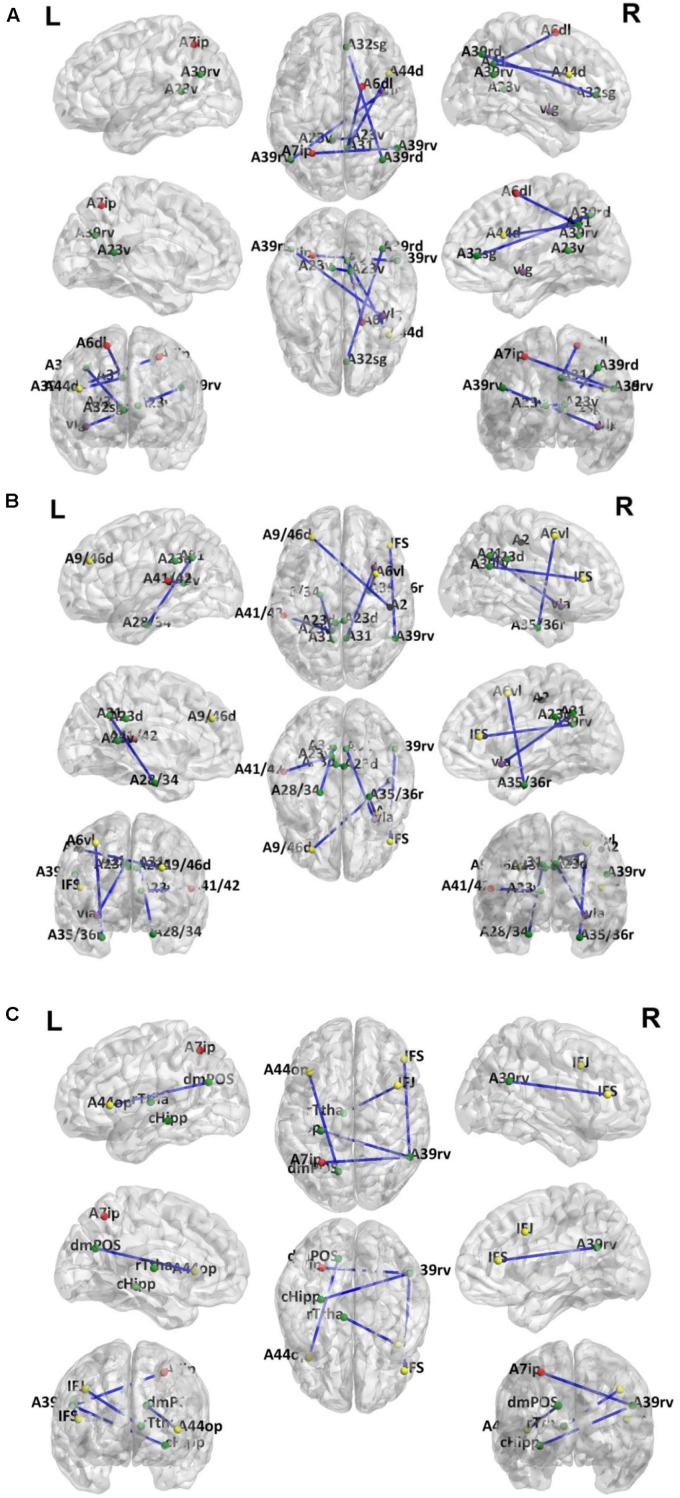
Dysfunctional connections with high discriminative power. (A) Six connections for T2DM-CI versus HC; (B) Seven connections for T2DM-NC versus HC; (C) Five connections for T2DM-CI versus T2DM-NC. The blue lines represent connections used for classification. Dots represent brain subregion nodes connected to these connections. Different colored dots represent subregions from different resting state network. The green dots indicate subregions of DMN, the red dots indicate subregions of FPN, yellow dots indicate subregions of ECN, purple dots indicate subregions of SAN and black dots indicate subregions of DAN.